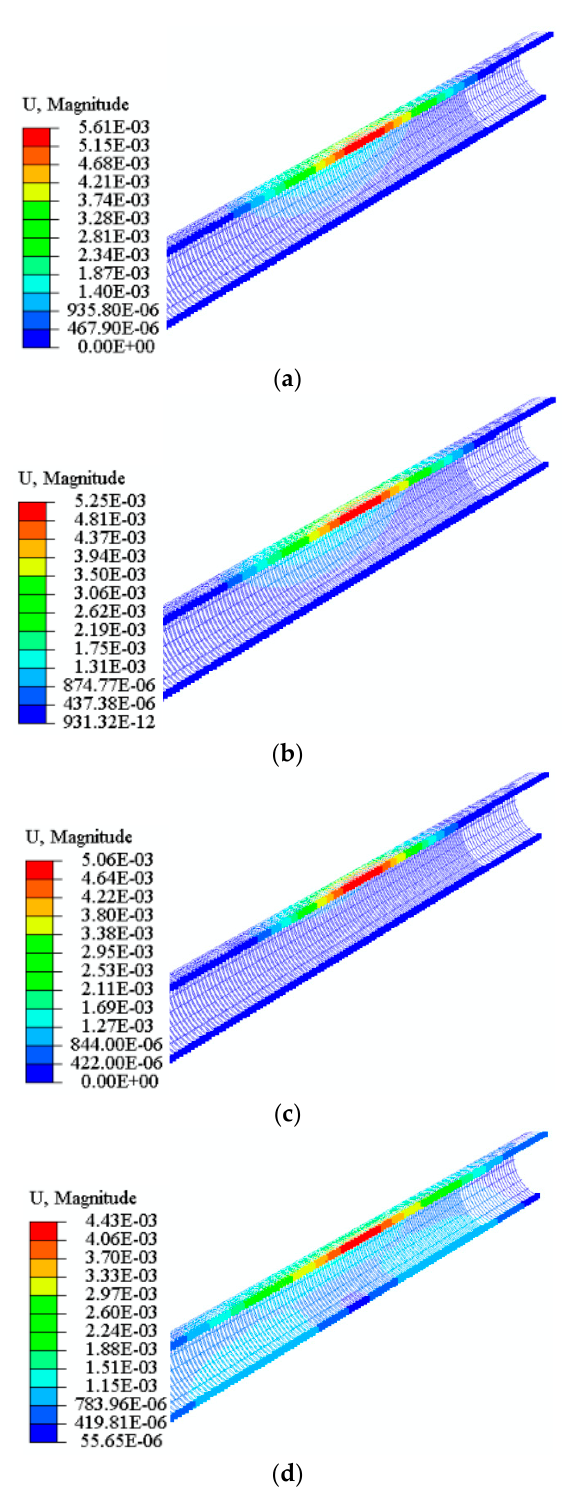
Figure 11. Deformation contours of steel bar reinforcement cage for ( a ) Jhingurda, ( b ) Singrauli, ( c ) Jamrani, and ( d ) Kota sandstone tunnel when an impact loading occurs due to a 100 kg missile.